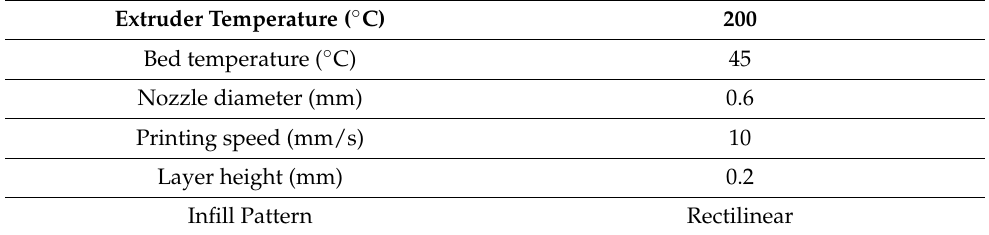
Table 1. 3D Printing